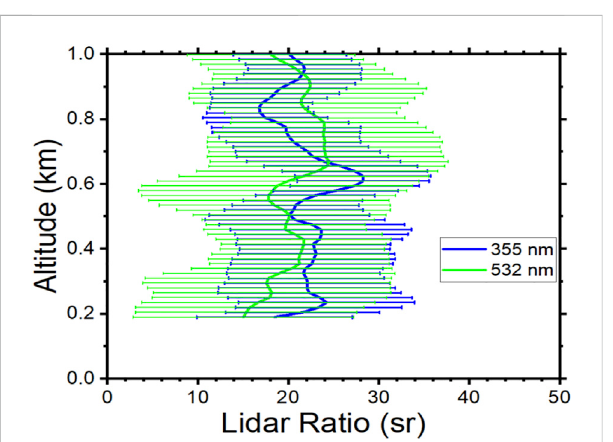
FIGURE 3 Average pro fi les of the lidar ratio derived from HSRL-2 observations at 355 and 532 nm during two fl ights (14:36 – 16:35 UT and 18:36 – 21:33 UT) on 8 March 2020. Error bars represent standard deviation of the measurements.